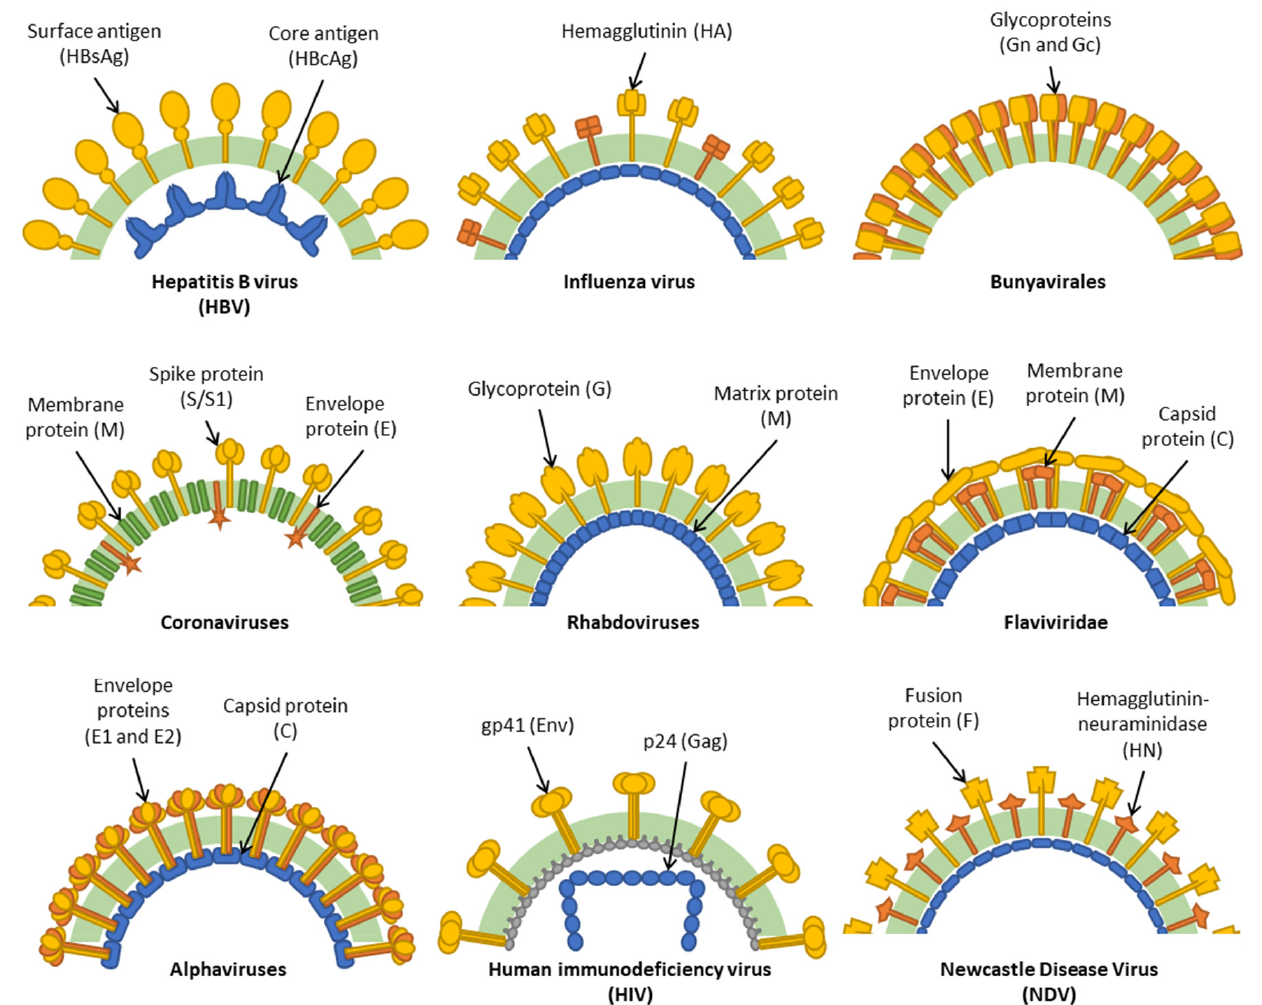
Figure 1. Diagrams depicting the major structural elements of the virus clades described in this review. Background dark green band represents the lipid envelope, and other elements represent viral structural proteins. Blue represents capsid proteins while yellow/orange represents membrane-bound surface glycoproteins.